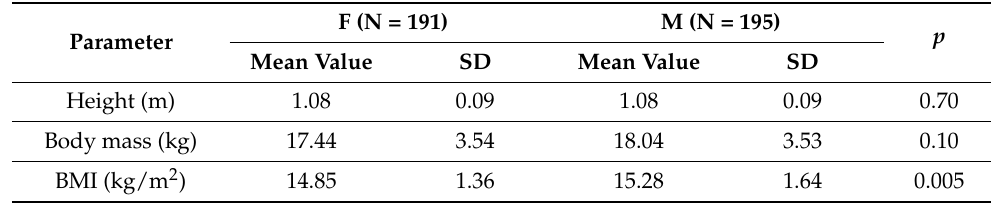
Table 2. Characteristics of the study group by